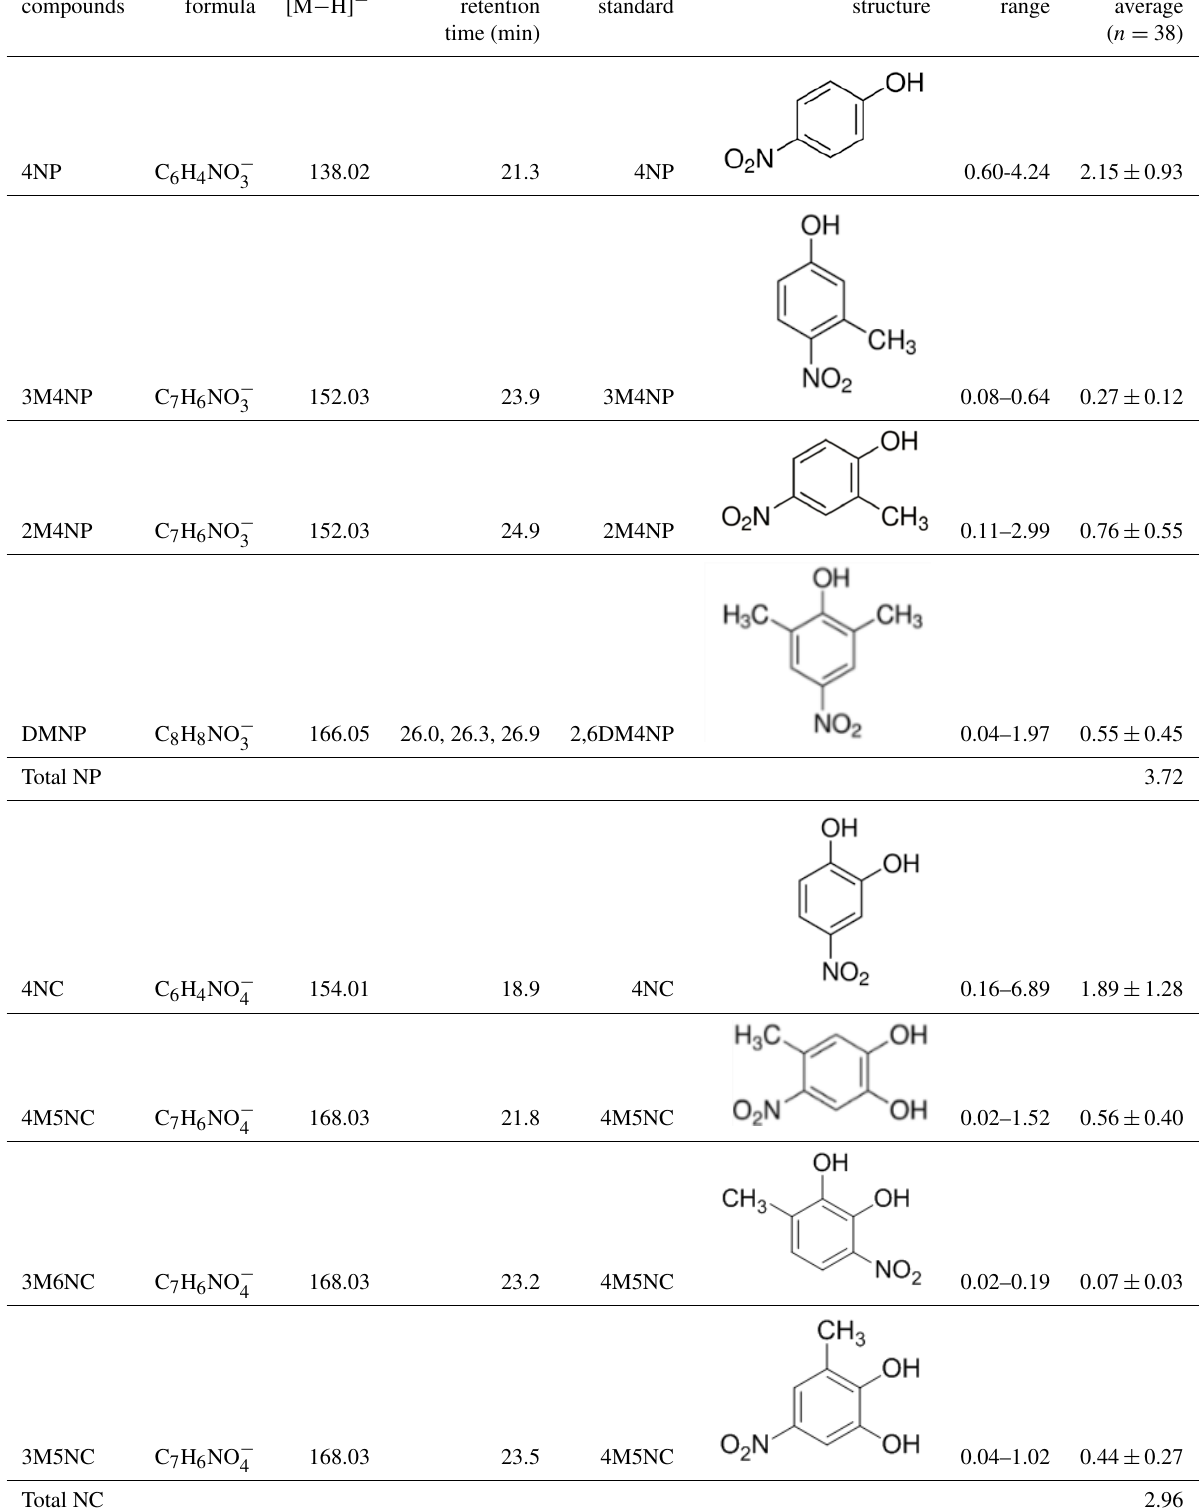
Table 1. The quantified nitro-aromatic compounds in this study.